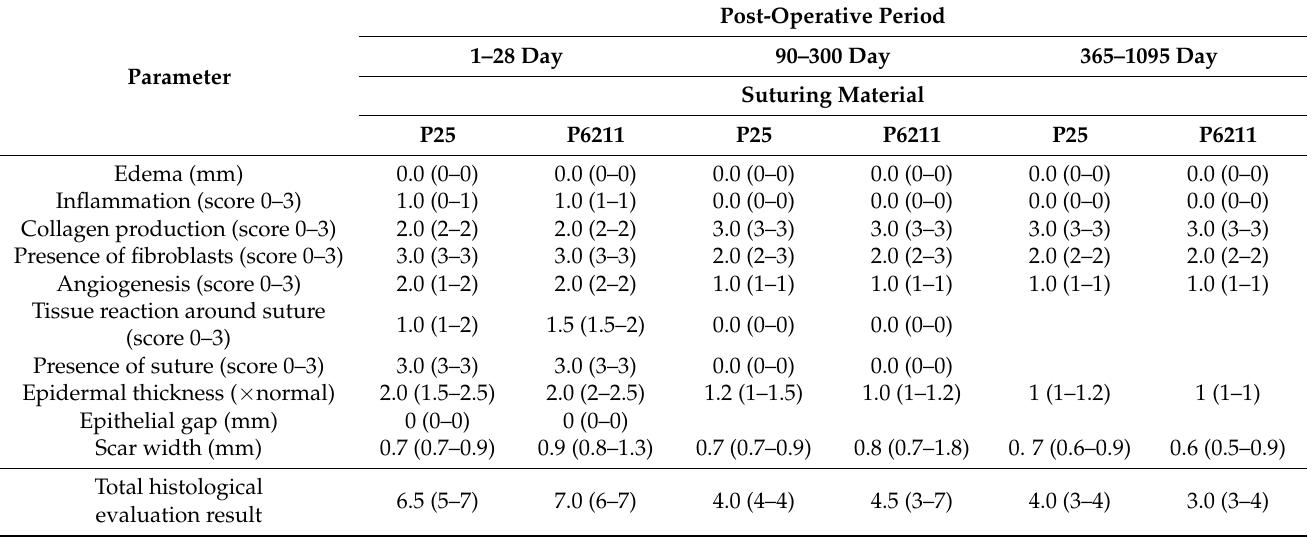
Table 3. Results of histological evaluation for each suturing material throughout the study (median values and interquartile length (in brackets)).